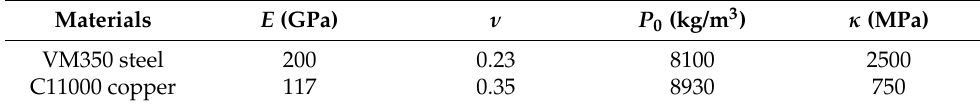
Table 4. The parameters of VM350 steel and C11000 copper.